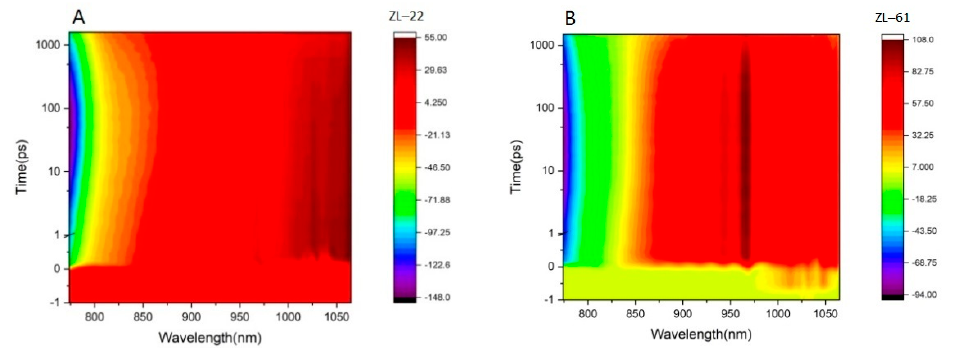
Figure 5. ( A , B ) 2--D contour plot of transient absorption as a function of probe wavelength and delay time for ZL-22 and ZL-61, respectively.